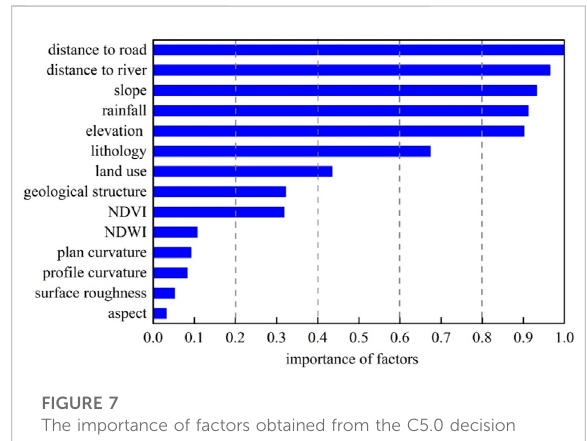
FIGURE 7 The importance of factors obtained from the C5.0 decision tree